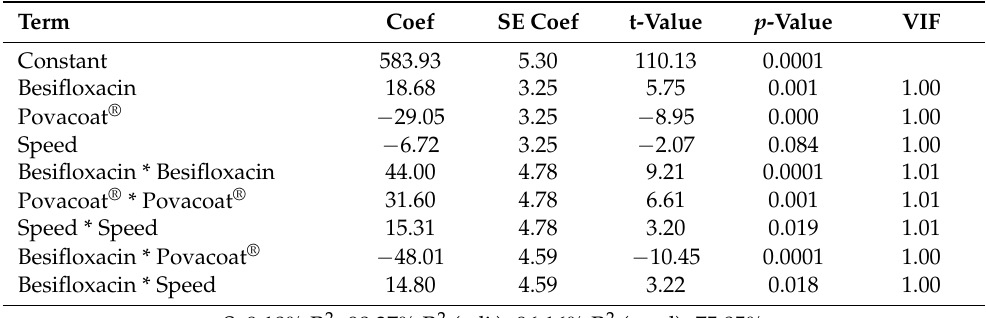
Table 4. Significance of coded regression coefficients and fit index of the selected model in evaluating Z-ave nanocrystals of besifloxacin.